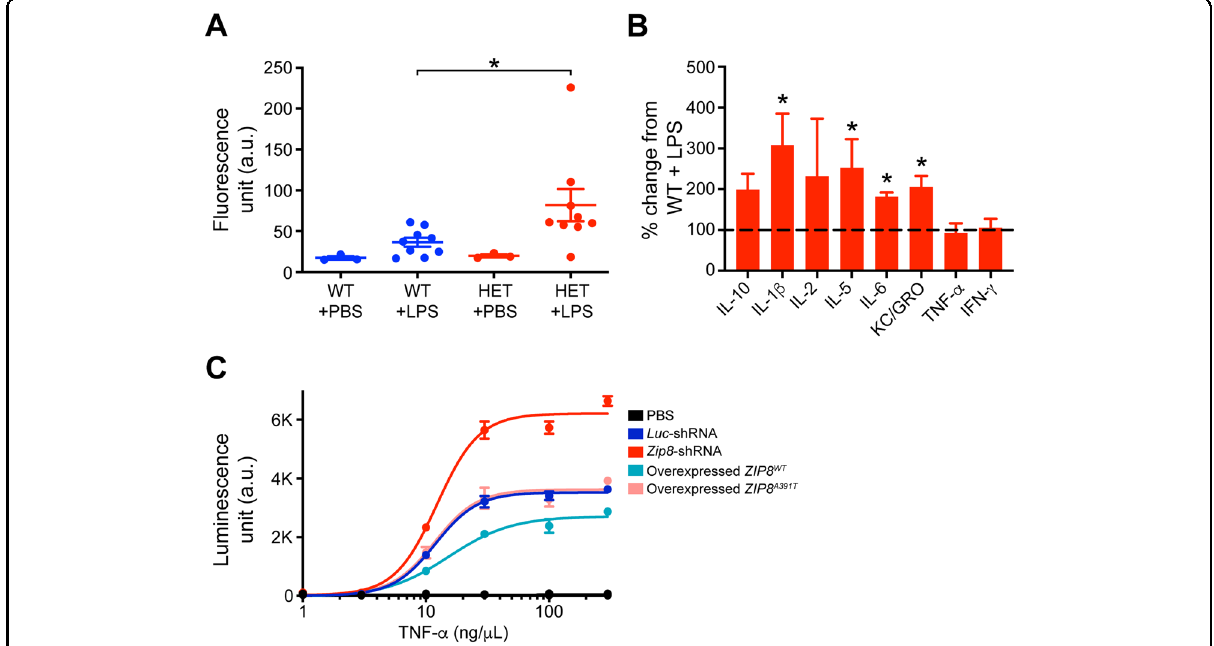
Fig. 5 ZIP8 loss-of-function results in increased BBB leakage and overactivation of NF κ B. A Intravenous retro-orbital sinus injection of Dextran- 488 after 24 h LPS treatment. Mice that were haplo-insuf fi cient for Zip8 demonstrated an elevated dextran 488 level compared to WT mice. * P < 0.05 (Student ’ s t -test; n = 3 per PBS-treated group and n = 7 – 10 per LPS-treated group). Error bar, SEM. B Zip8 HET mice after 24 h LPS treatment displayed increased levels of several plasma cytokines compared to WT mice (one-way ANOVA followed by Tukey ’ s multiple comparison test, * = signi fi cant difference between WT LPS and HET LPS conditions: KC/GRO, P = 0.042; IL-5, P = 0.05; IL-1 β , P = 0.05; IL-6, P = 0.002; see Fig. S2). Cytokine levels from WT mice treated with LPS were averaged and used for normalizing cytokine response from Zip8 HET mice treated with LPS ( n = 17 per group). Error bar, SEM. C In HEK293 cells stably expressing a 3xNF κ B reporter, Zip8 -shRNA transient transfection led to increased NF κ B activation compared to Luc - shRNA transiently transfected cells, whereas cells transfected with ZIP8 WT plasmid displayed a protective effect compared to cells transfected with ZIP8 A391T plasmid, which had no effect on the WT background (two-way ANOVA followed by Bonferonni ’ s post hoc test; TNFa vs. manipulation interaction ( P < 0.0001). See Table S1 for details. Error bar,